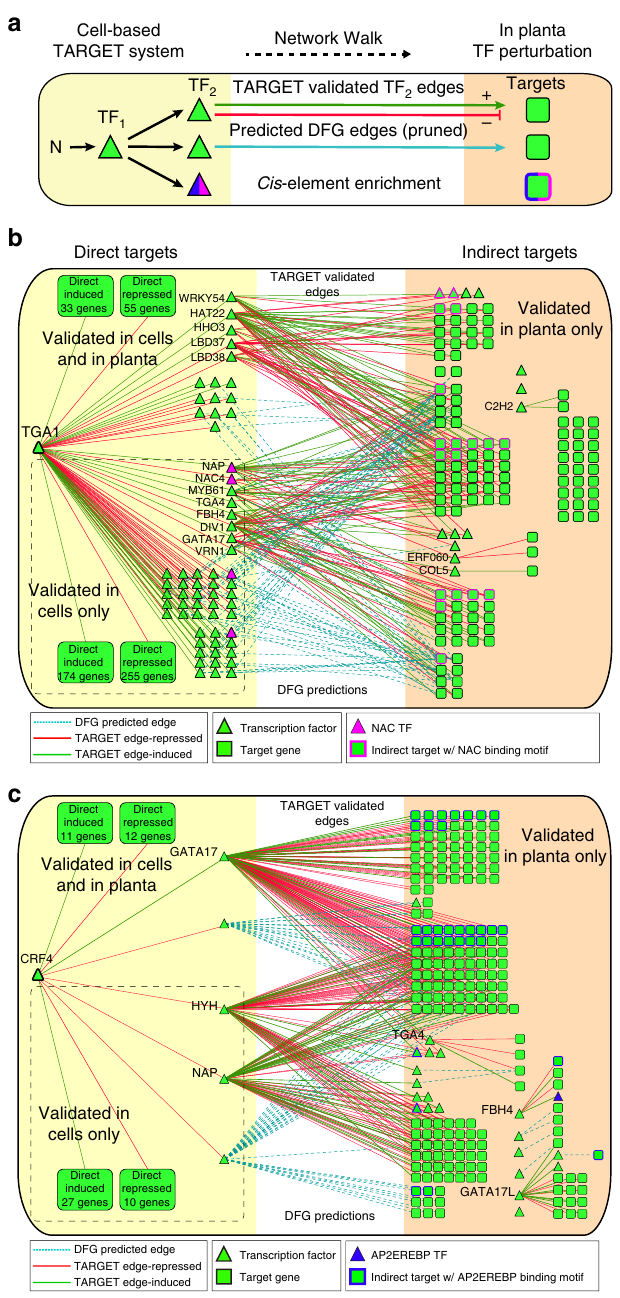
overexpression in planta (247 genes) is similar to the number responding to TGA1 overexpression in planta (208 genes) (Fig. 7b, c). In the CRF4 Network Walk, we identi fi ed direct connections of CRF4 to only 5 intermediate TF 2 s (GATA17, NAP, HYH, MYB34, bHLH112), which in turn accounted for the regulation of 87% of CRF4 indirect targets in planta. Thus, a Network Walk not only identi fi es the network path for each TF 1 via its downstream TF 2 s, but can also help classify TF modes of action, as discussed below.